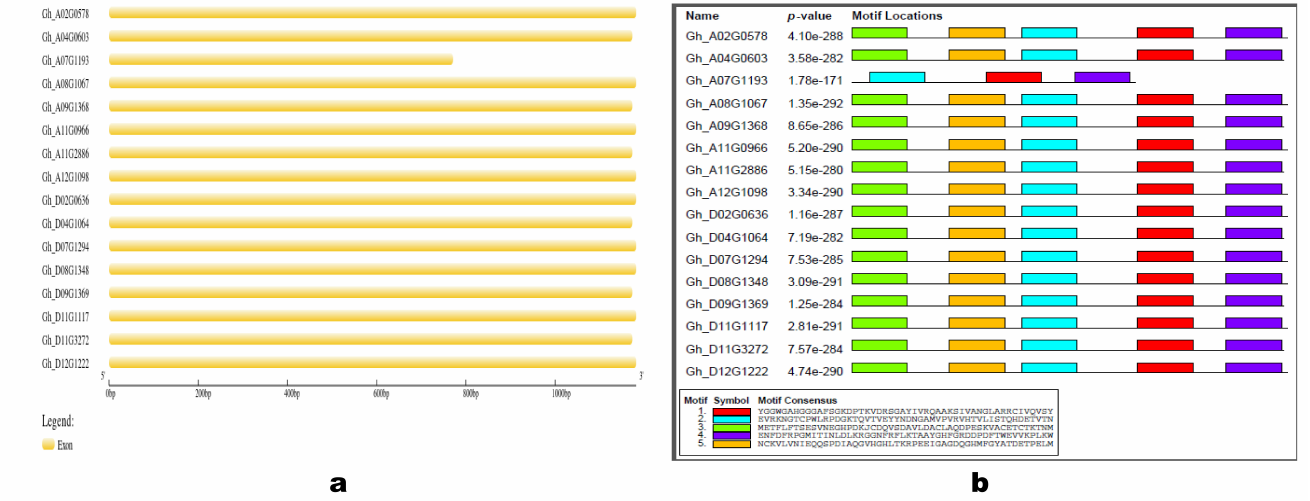
Figure 2. GhSAMS genes’ structure ( a ), and conserved motifs in their promoter region ( b